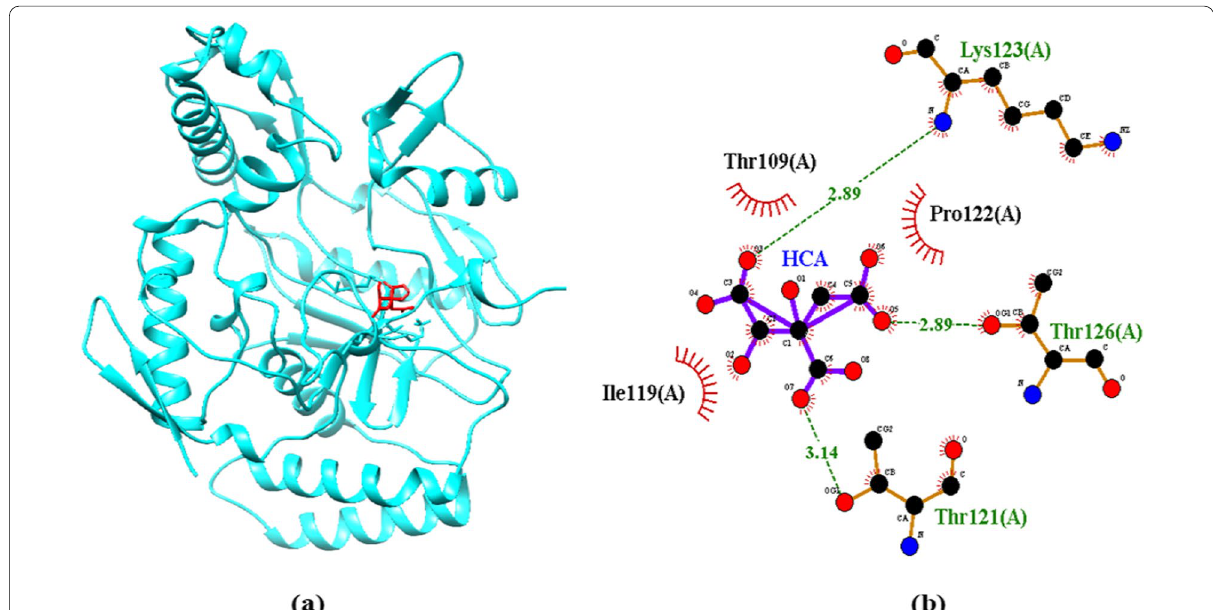
Fig. 11 Docking images of protein (iNOS) and ligand (Hydroxycitric acid). a Shows the 3D interaction between HCA (red) and iNOS (blue). b LigPlot image showing the H-bond (Thr121, Lys123, Thr126) interactions and hydrophobic interactions (Thr109, Ile119, Pro122) between HCA and + iNOS